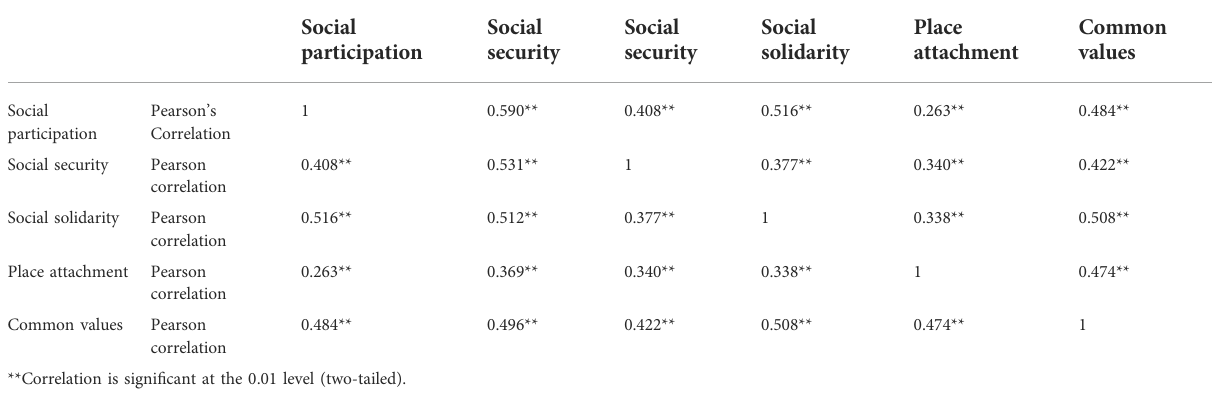
TABLE 7 Correlation of social capital